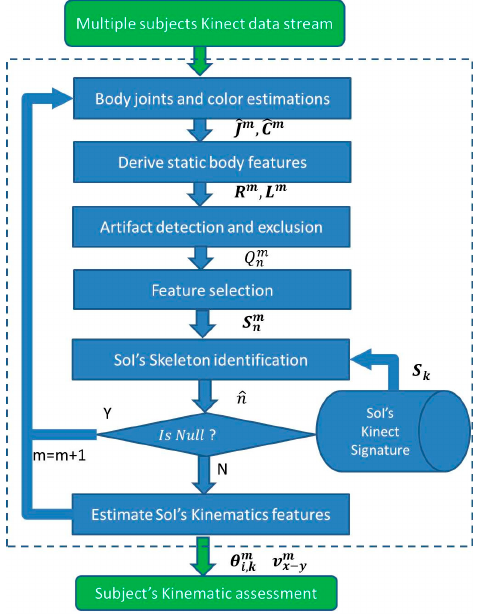
Figure 1. Data analysis scheme flowchart: joint estimation, static features estimation based on the joints’ estimation, feature selection, artifact detection and exclusion in the feature domain, identification of the SoI skeleton based on the KS, and after the KS is assigned to the right subject, kinematic features for kinematic analysis can be derived.